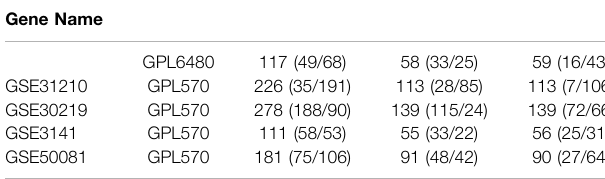
TABLE 3 | Information of GEO data sets used in the validation of the